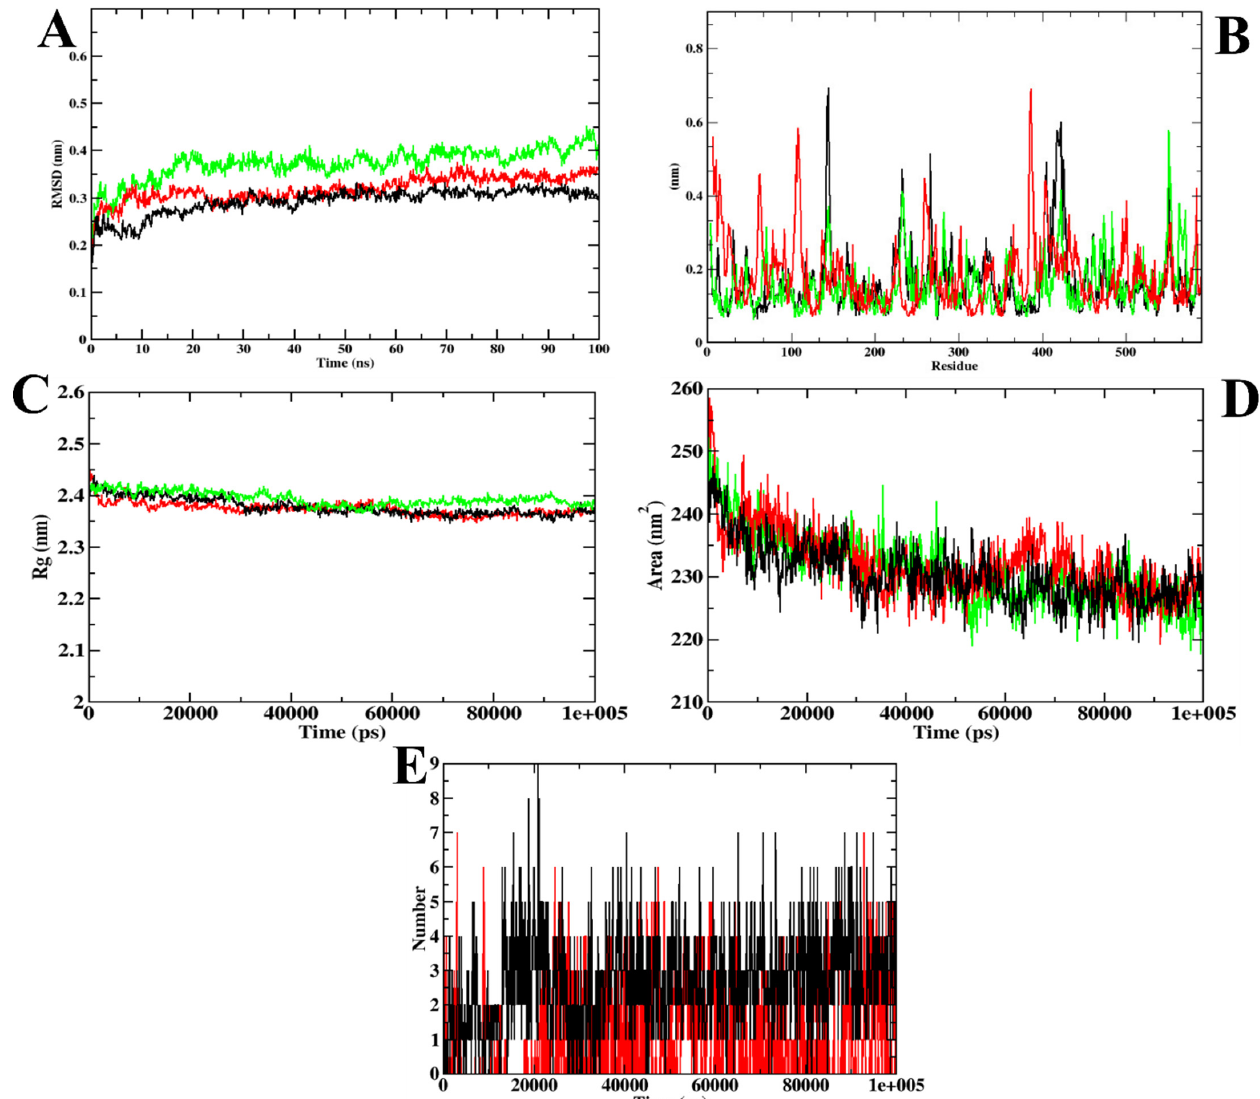
Figure 9. Visualization of MD trajectories obtained for ZINC02789441 and acarbose complexed with α -glucosidase; ( A ) RMSD, ( B ) RMSF, ( C ) Rg, ( D ) SASA, and ( E ) SASA. Green: apoprotein, red: protein–acarbose complex, and black: protein–ZINC02789441 complex. In addition to α -glucosidase, ZINC02789441 was simulated with α -amylase. The